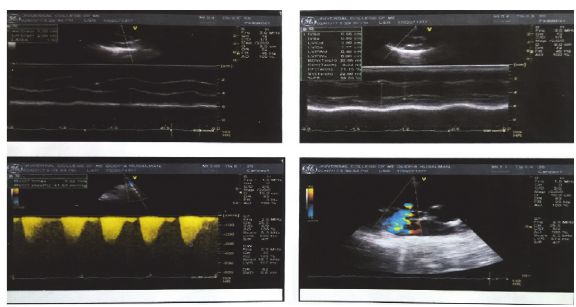
Figure 4: Showing echocardiographic